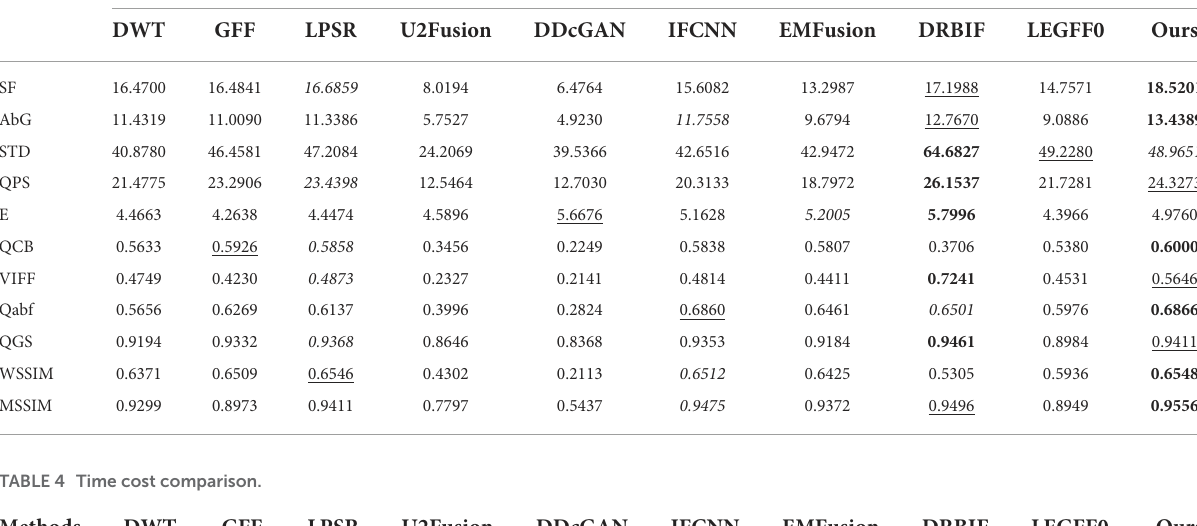
TABLE 3 Quantitative evaluation results on the SPECT-MRI dataset.